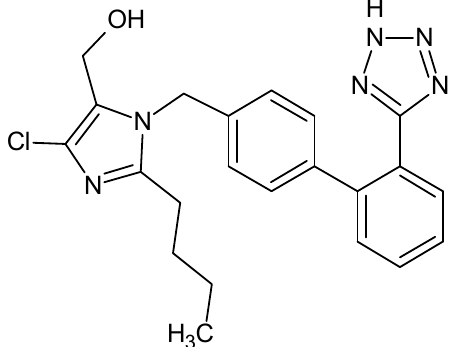
Figure 1. Structural formula of losartan (LOS) (ChemSketch 12.1.0.31258).